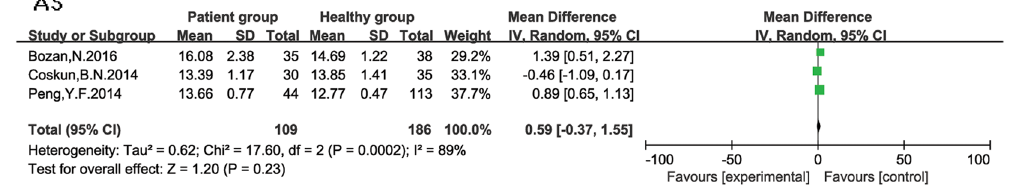
Figure 5. Forest plot of relationship between RDW and